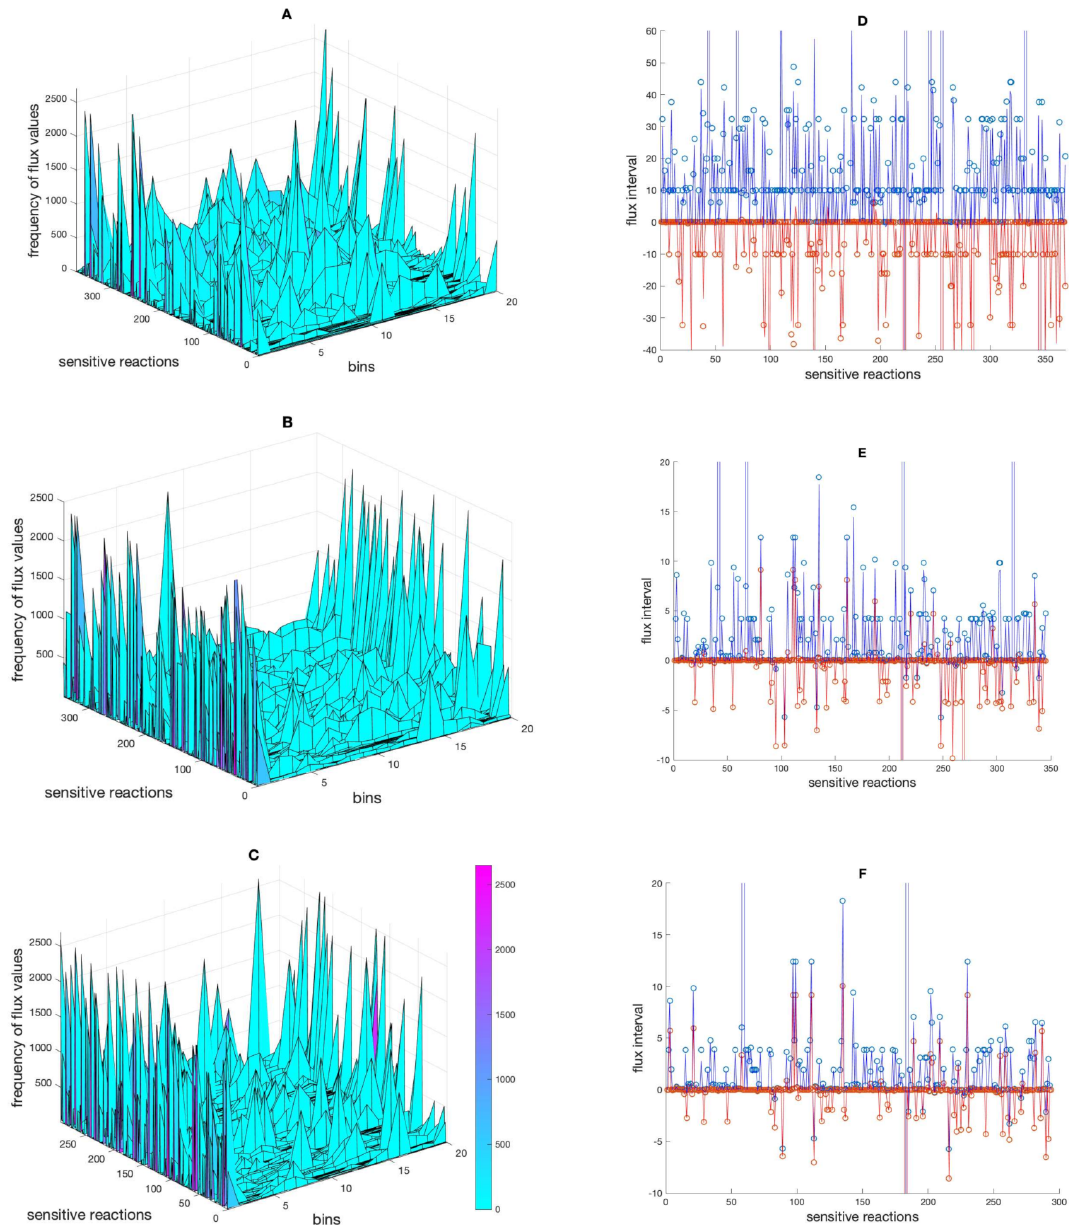
Figure 2. The distribution of alternative flux values across the flux intervals. Panel ( A – C ) show the frequency of flux values of sensitive reactions divided into 20 bins in the mt + med, mt + med + met and mt + med + met + pro models, respectively. Panel ( D – F ) show the intervasl in the respective models in which sensitive reactions responded to perturbations (red and blue lines, indicating lowest and highest flux values, respectively), and the interval given by FVA, indicated by red dots (lower bounds) and blue dots (upper bounds). For the sake of clarity, a few extreme points in panel ( D – F ) are